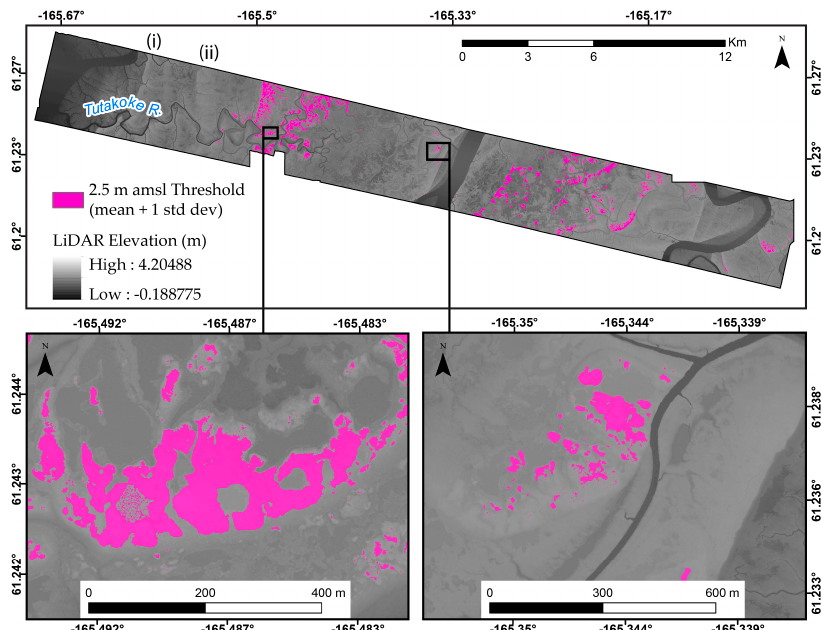
Figure 8. High-resolution map of permafrost distribution created using the 2.5 m a.m.s.l. (mean + 1 SD) threshold for the entire 2009 LiDAR swath. The insets show more detail in areas of relative high elevation ( left ) and areas of relative low elevation ( right ). Transitions between the mudflat and active floodplain deposit (i), and active and inactive floodplain deposits (ii) are also